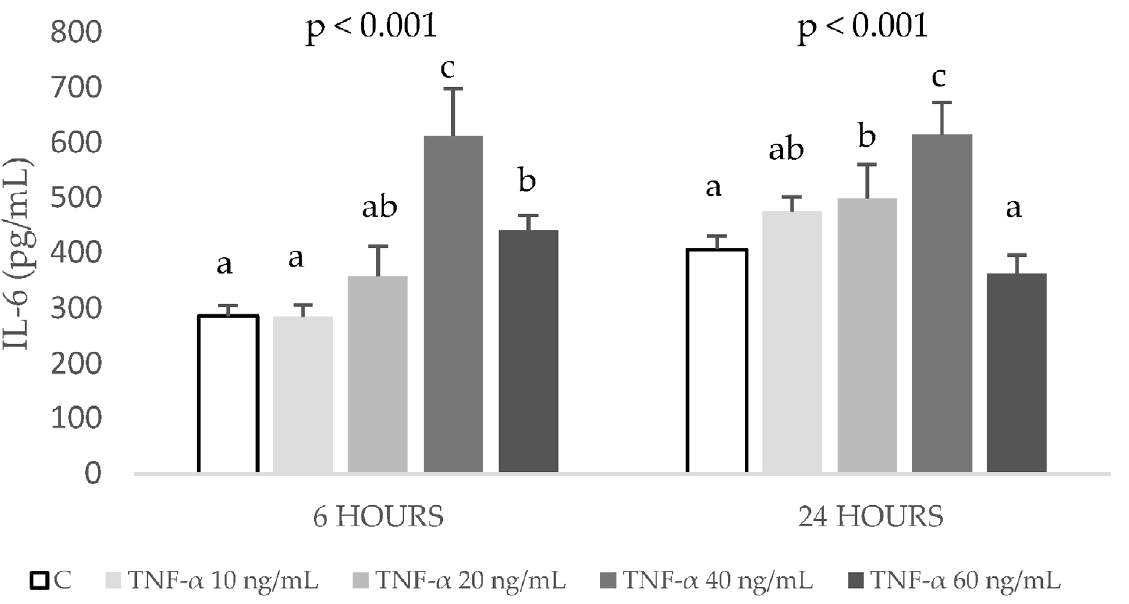
Figure 1. Production of interleukin-6 (IL-6) after exposure to 0 (control, C), 10, 20, 40 and 60 ng/mL of TNF- α during 6 and 24 h in HepG2 cell cultures. Results, expressed as pg/mL, are means ± SD (n= 3–6). The p values above the figures represent ANOVA results and the different letters denote statistical differences within the same time according to the Bonferroni test ( p < 0.05).